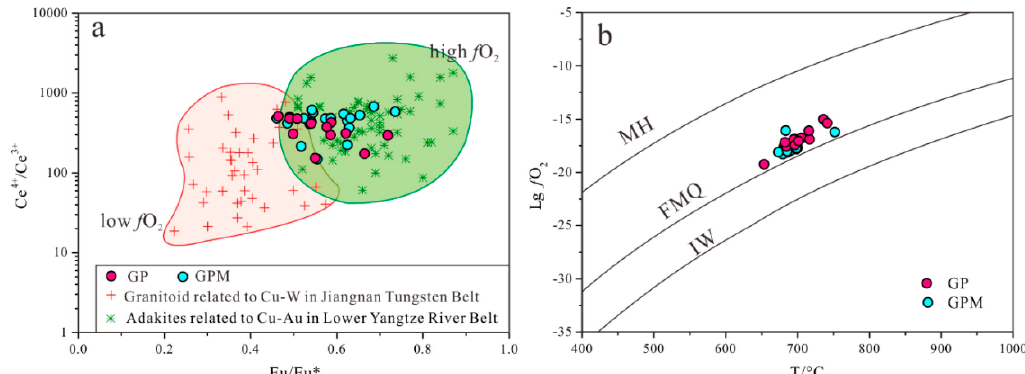
Figure 14. Plot of ( a ) Ce 4+ /Ce 3+ value vs. Eu/Eu* value and ( b ) log f O 2 vs. T (°C) of zircon samples from the Qiaomaishan intrusions. Zircon Ce 4+ /Ce 3+ and Eu/Eu* values are calculated using the method in